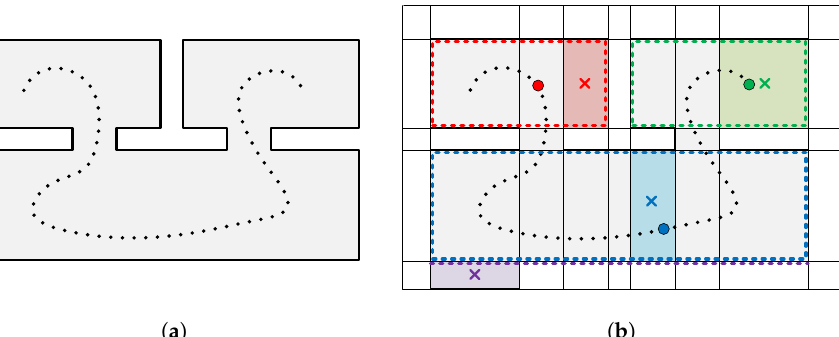
Figure 6. Illustration of an indoor space consisting of three rooms and two inter-room connections expressed in 2D for visualization. The ( a ) structural points (black lines) and trajectory points (black dots) and ( b ) decomposed 3D spaces. ( b ) illustrates centers of the cells (colored crosses), visible points in the cells (colored dots), and trajectory points with the smallest difference in visibility (colored circles) for each cell (colored boxes). The cells marked in red, green, and blue select the trajectory point with the smallest difference in visibility but a cell marked in purple, which is outside the indoor space, has large differences in visibility for all trajectory points.